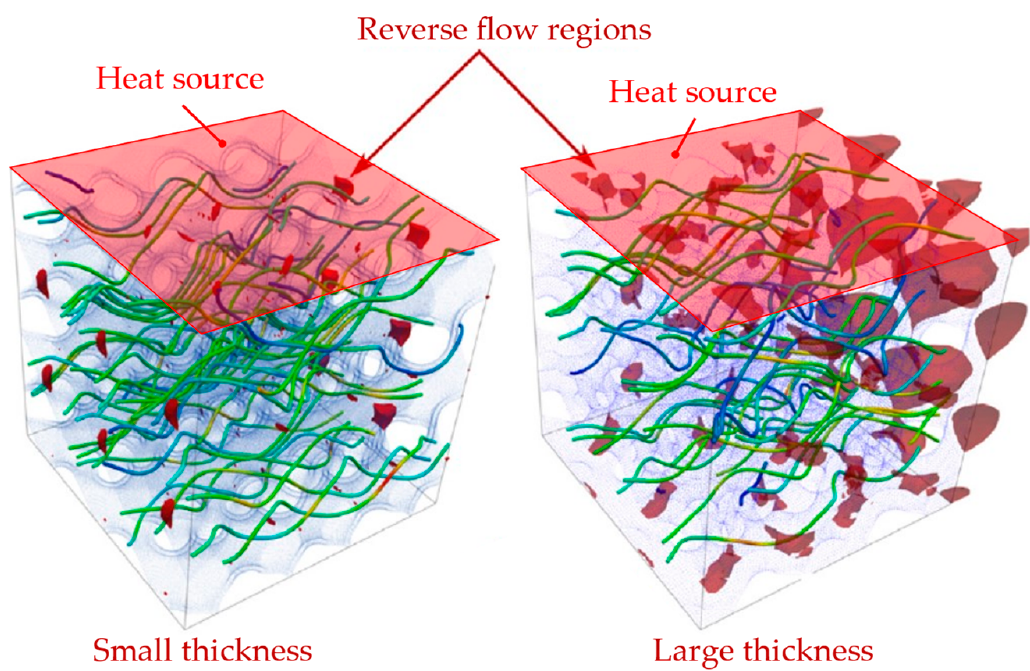
Figure 17. Demonstrations of reverse flow regions for small thickness ( left ) and large thickness ( right ) of the sheet-Diamond structure at a specific Reynolds number [52].